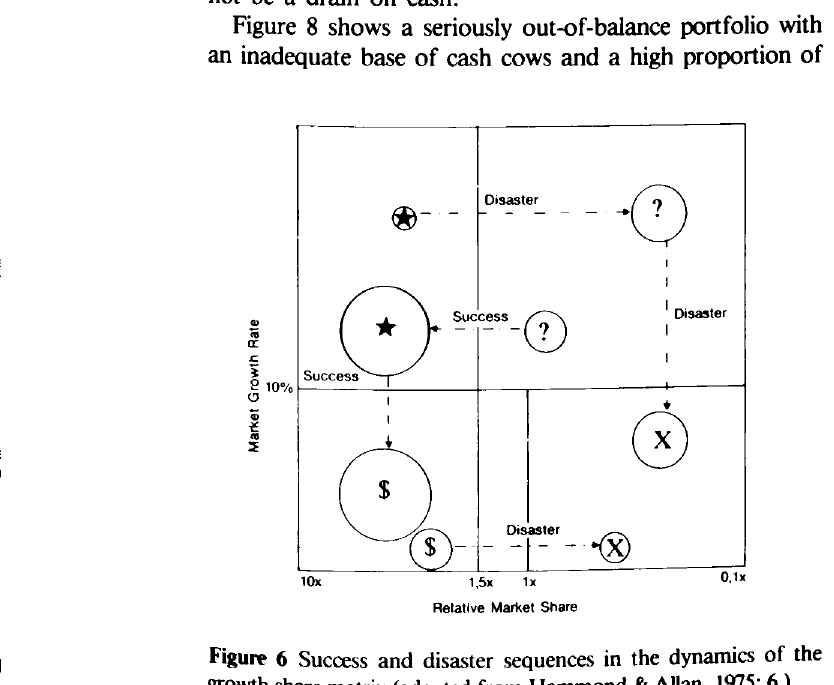
Figure 6 Success and disaster sequences in the dynamics of the growth share matrix (adapted from Hammond & Allan, 1975: 6.)